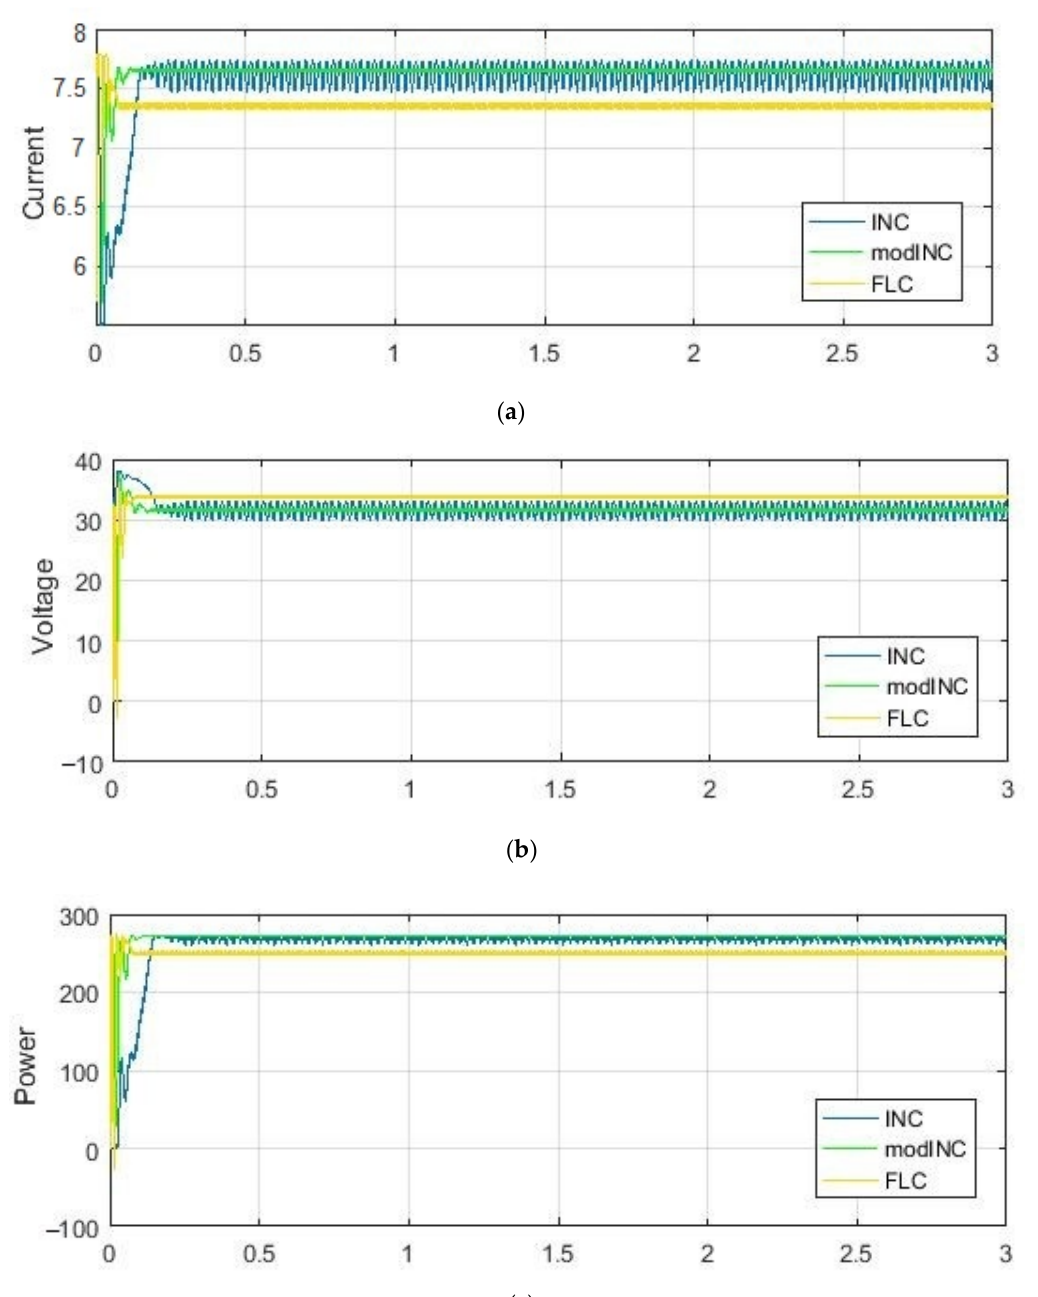
Figure 12. ( a ) Output current using INC, modINC, and FLC in STC. ( b ) Output voltage using INC, modINC, and FLC in STC. ( c ) Output power using INC, modINC and FLC in STC. STC. ( c ) Output power using INC, modINC and FLC in